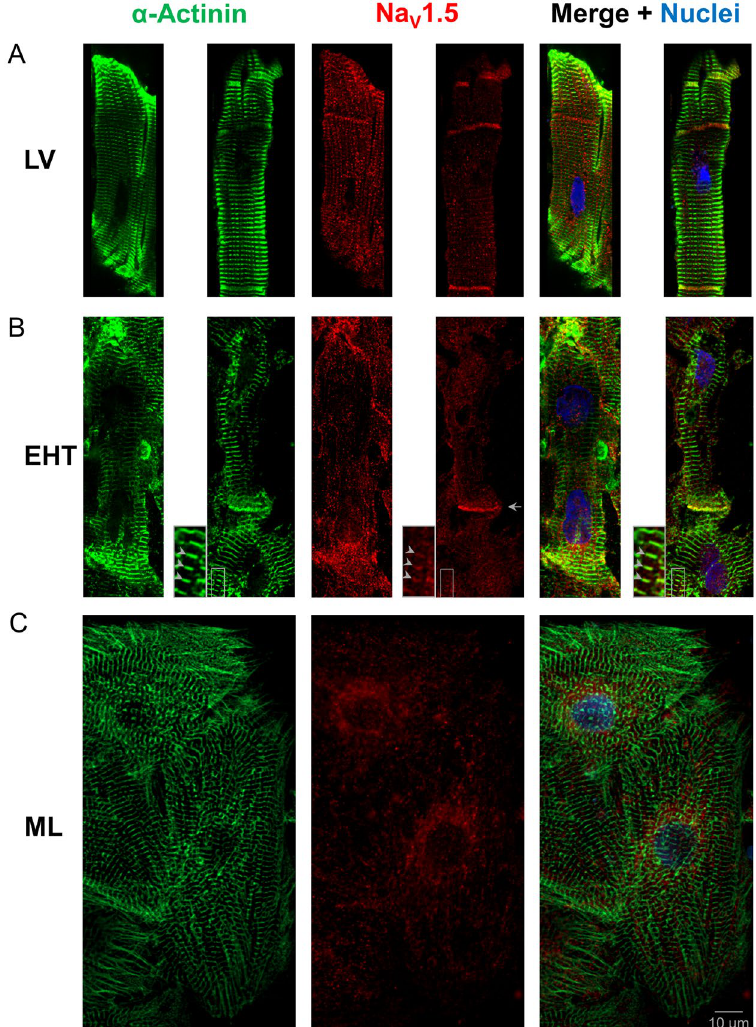
Figure 5. Immunofluorescence analysis. Subcellular localisation of α -actinin (green), Na V 1.5 (red) and nuclei (blue) in a whole mount immunofluorescent confocal section of left ventricular tissue (LV, two examples, A ) and human induced pluripotent stem cell-derived cardiomyocytes (hiPSC-CM) in engineered heart tissue (EHT, two examples, B ) and monolayer (ML, C ). In contrast to ML, EHT showed a parallel orientation of CM, a more rod-shaped morphology, sarcomere alignment and Na V 1.5 enhancement at cell-cell contact (arrow). In some parts of the EHT, Na V 1.5 was co-localised with α -actinin at Z-disks (see arrowheads in inset with 2.5 fold magnification), comparable to LV. Scale bar for all images is 10 µ m. Black rectangles were placed aside confocal images in A for symmetrical